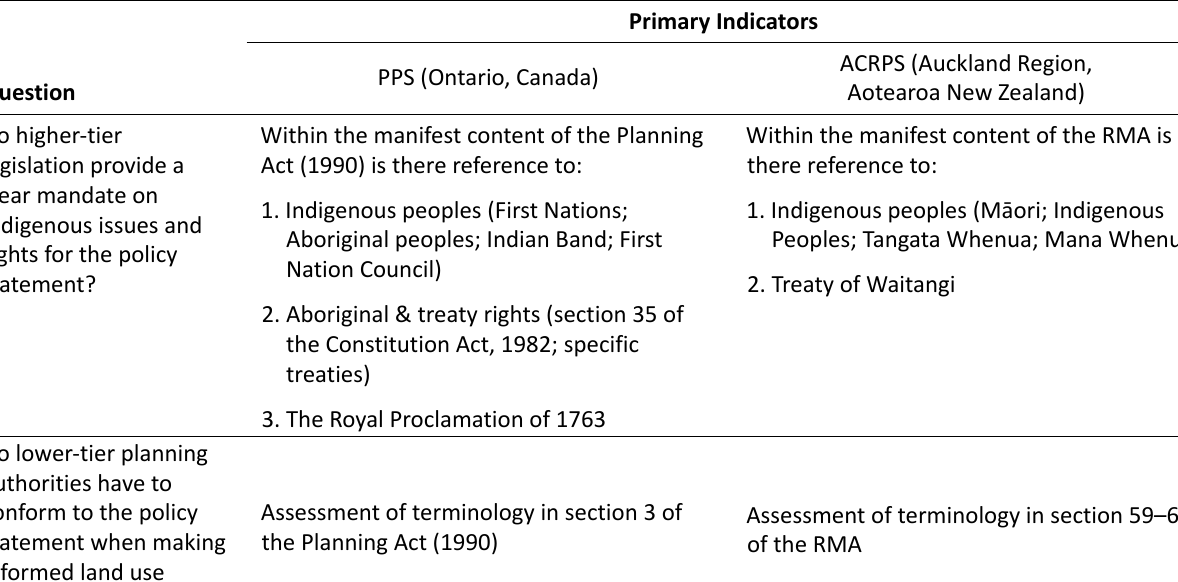
Table 1. Key aspects to Clarity in reference to the Ontario Provincial Policy Statement and the Auckland Council Regional Policy